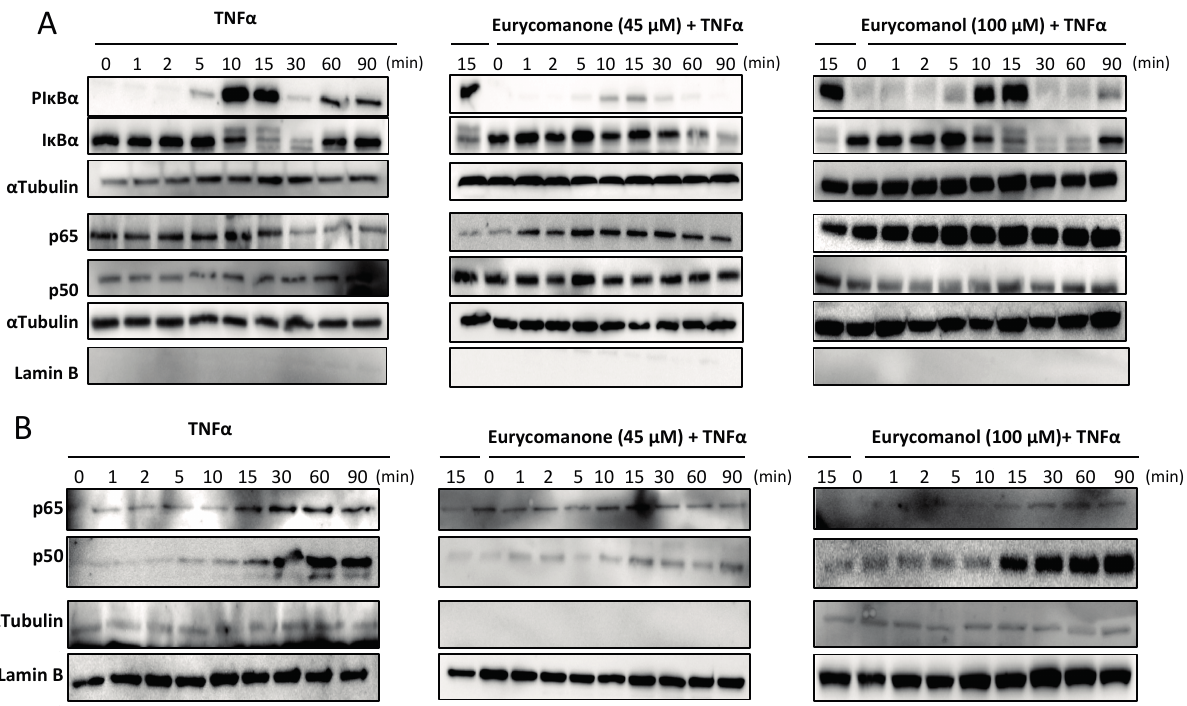
Figure 8. The effect of eurycomanone and eurycomanol on I κ B α degradation and on p65 and p50 nuclear translocation. Jurkat cells were pre-treated with eurycomanone (45 μ M) and with eurycomanol (100 μ M) for two hours followed by activation with TNF α (20 ng/mL) for the indicated time periods. Cytoplasmic ( A ) and nuclear ( B ) extracts were tested for P-I κ B α , I κ B α , p50 and p65. Protein loading and purity of extracts were verified by lamin B and α -tubulin controls. Data are representative of three independent